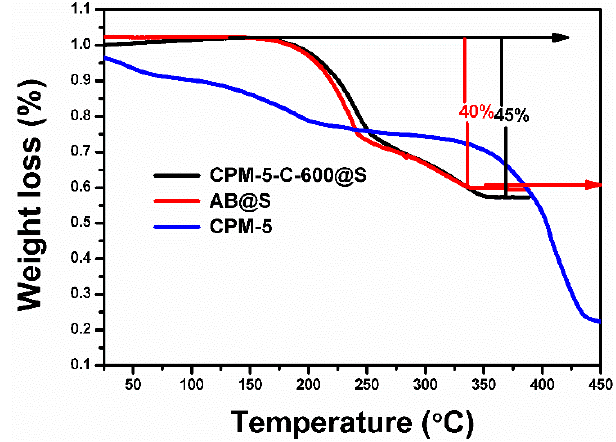
Figure 5. TGA curves of the CPM-5, CPM-5-C-600@S and AB@S composites.